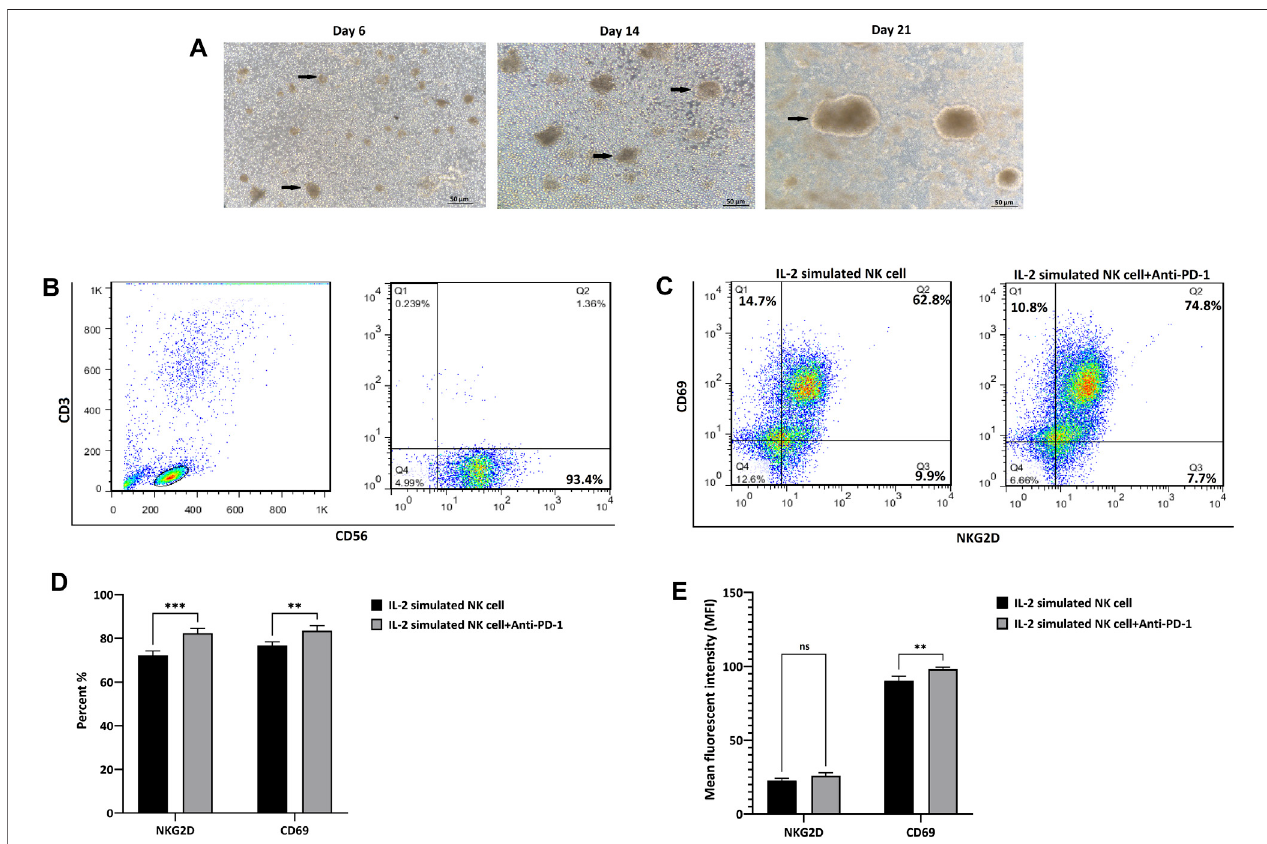
FIGURE 2 | Isolation, characterization , and expansion of NK cells. (A) The morphology of NK cells after 6, 14, and 21 days of round-shaped colony of NK cells is illustrated by arrows. (B) The frequency of CD56+CD3-NK cells in PBMC-derived NK cells, after MACS isolation with more than 93.4% purity. (C) The frequency of NKG2D and CD69 marker before and after treatment of IL-2-stimulated NK cells by anti-PD-1 antibody. (D) The quanti fi cation of positive cells for NKG2D and CD69 marker. (E) The quanti fi cation of mean fl uorescence intensity for NKG2D and CD69 marker. Data presented as means ± standard error (M ± SE) for three independent experiments. Statistical signi fi cance was determined using one-way ANOVA with * p < 0.05. Scale bar: 50 µm, magni fi cation 200X. ns, not signi fi cant.